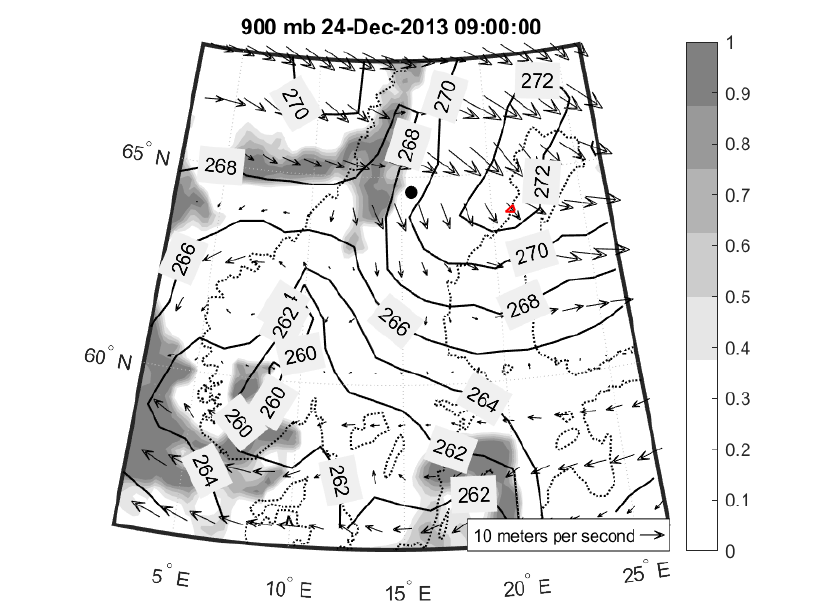
Figure 14. ECMWF ERA5 reanalysis: Cloud fraction (shading), wind vectors (m/s), and temperature (K; contours) at 900 millibars at 09:00 UTC 24 December 2013 over Scandinavia. MUSC was initialized at the location of the black